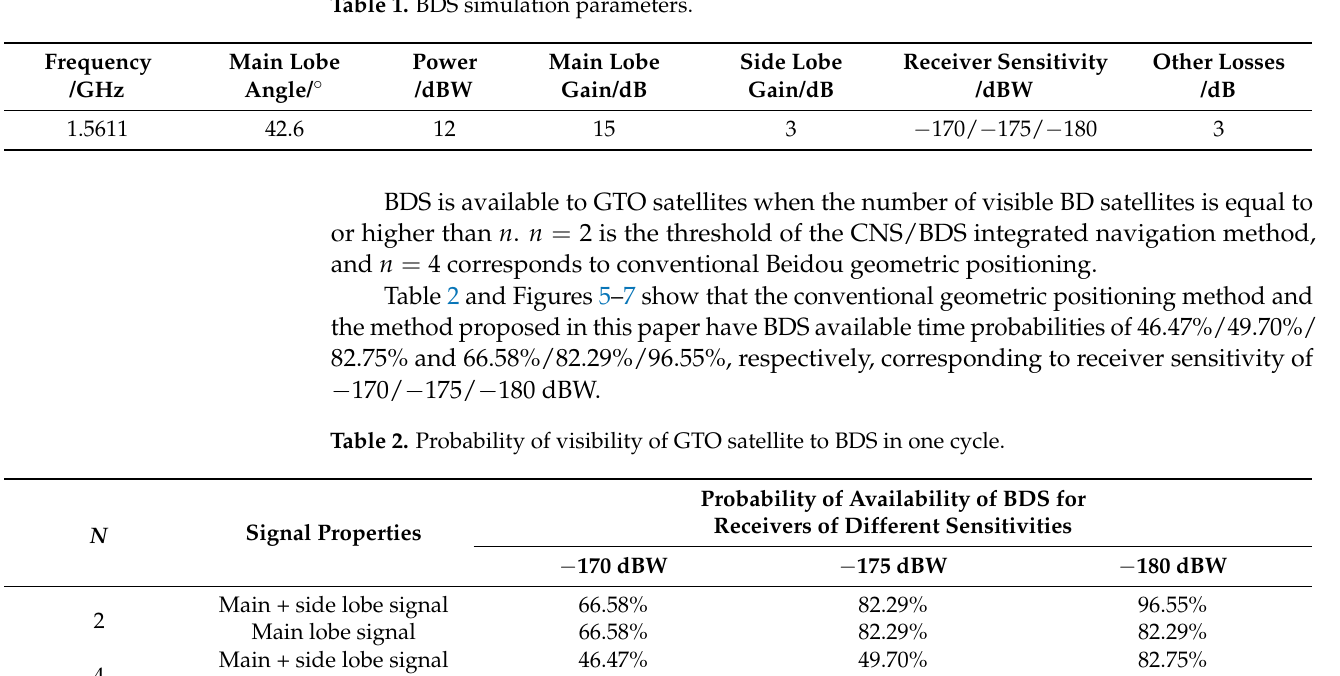
Table 1. BDS simulation parameters.